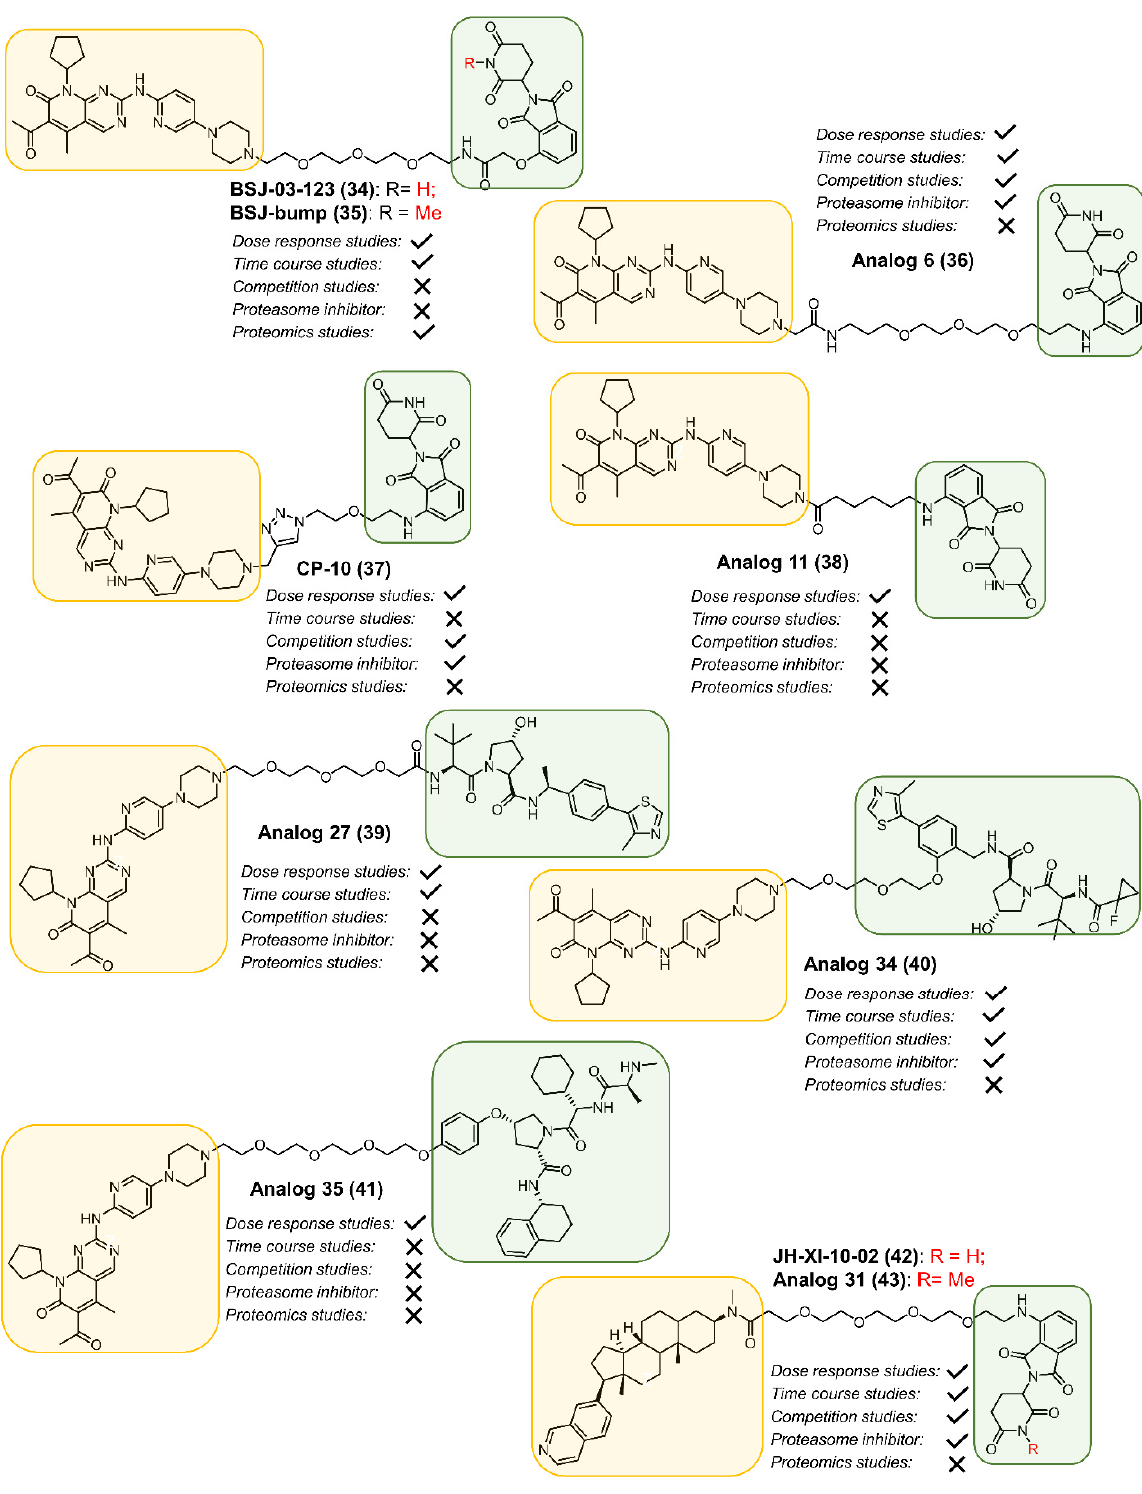
Figure 7. Structures of CDK6 ( 34 , 36–41 ) and CDK8 ( 42 )